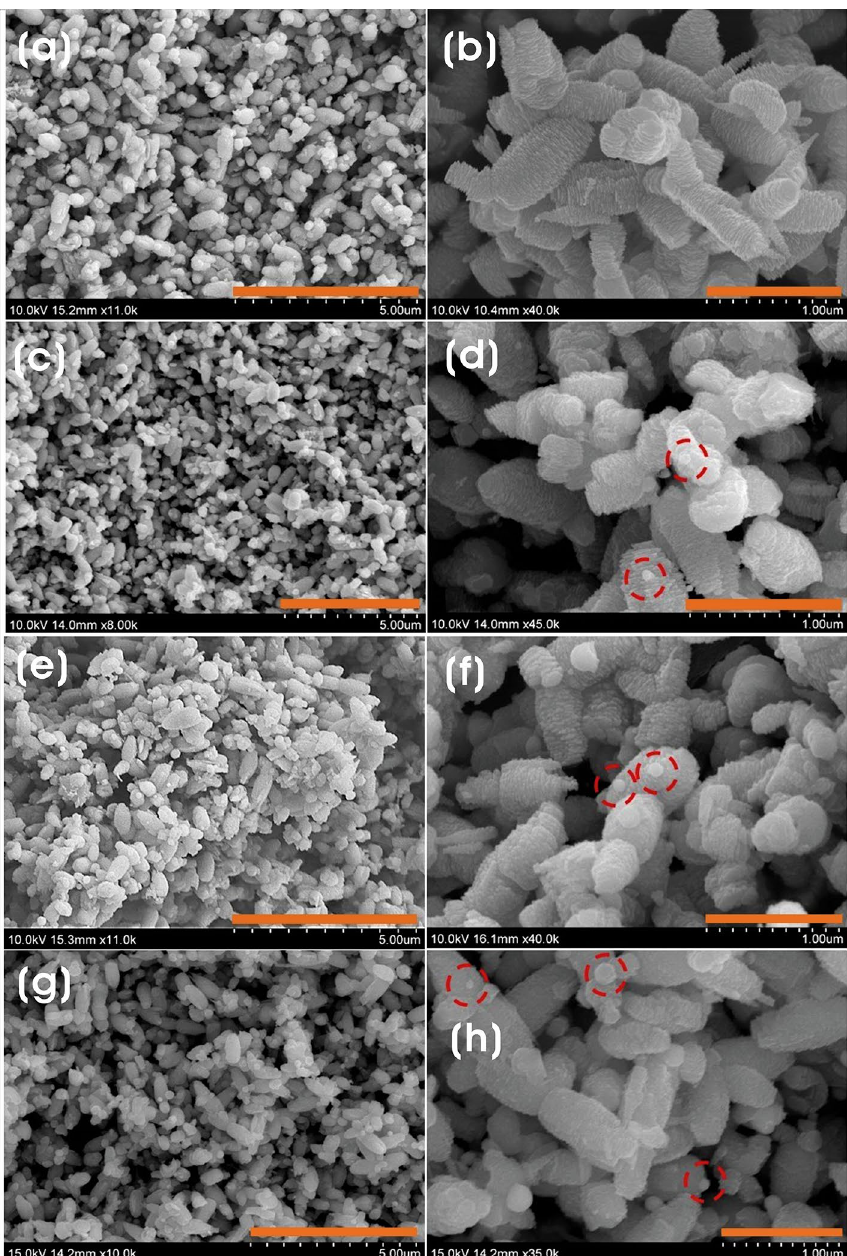
Figure 4. FE-SEM micrographs of ( a , b ) ZnO, and ( c , d ) Ag 0.2 @ZnO, ( e , f ) Ag 0.4 @ZnO, and ( g , h ) Ag 0.8 @ZnO NCs (scale bar 5 µm (left) and 1 µm